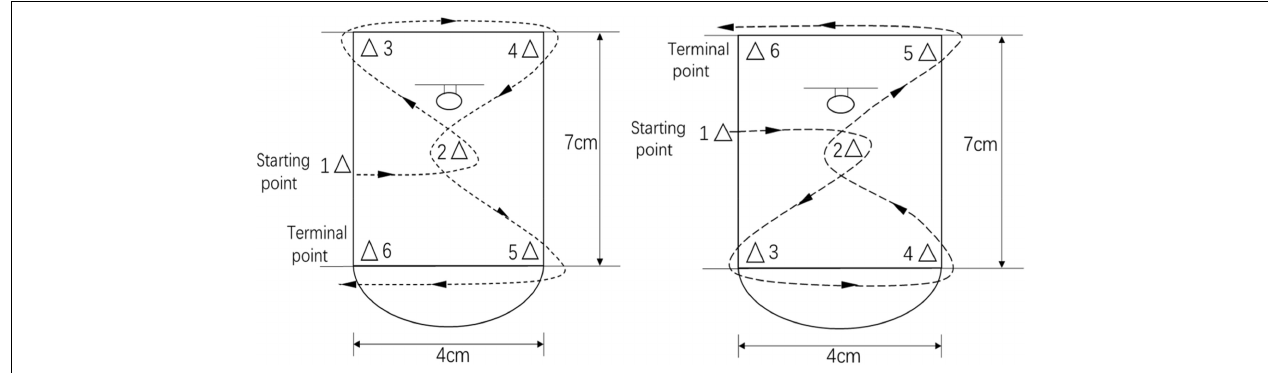
FIGURE 2 | Dribbling test diagram.In the above illustration, on the left is the left-hand ball; the context is a specified basketball court; the specified time and the ball route are shown by the dotted line.